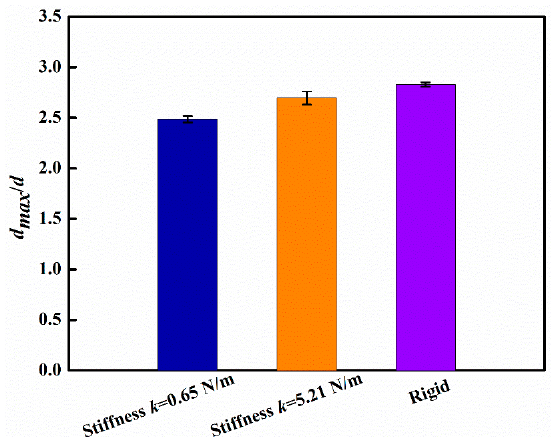
Figure 6. The ratio of droplet maximum spreading diameter to initial droplet diameter on the surfaces with di ff erent sti ff membrane surfaces with different stiffness.